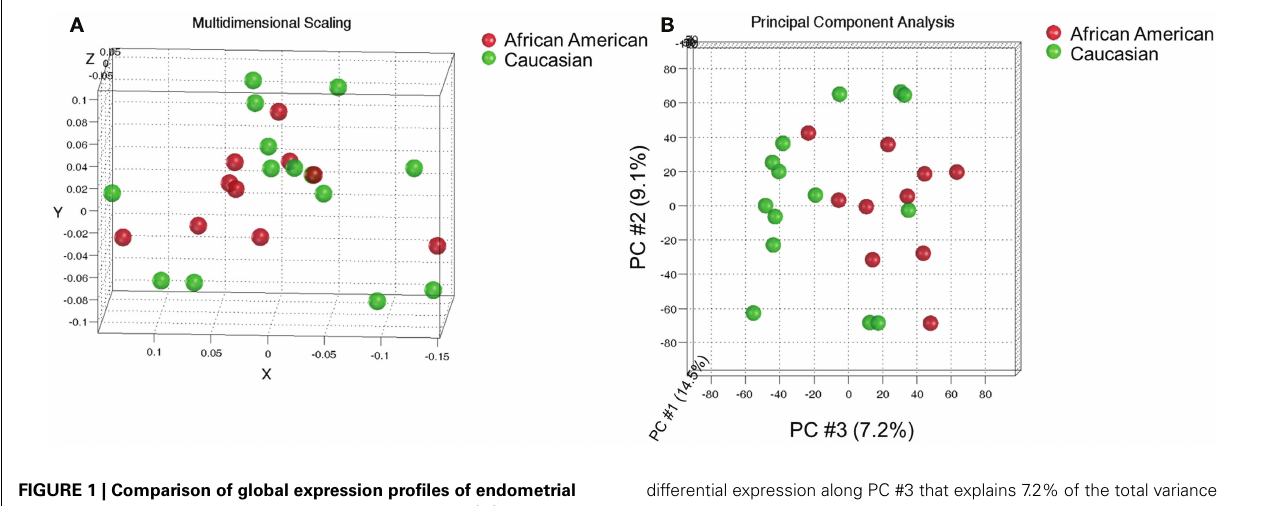
FIGURE 1 | Comparison of global expression profiles of endometrial cancers fromAfrican-American and Caucasian women. (A) Multidimensional scaling using 1-correlation as distance metric did not distinguish the classes. (B) Principal component analysis indicates